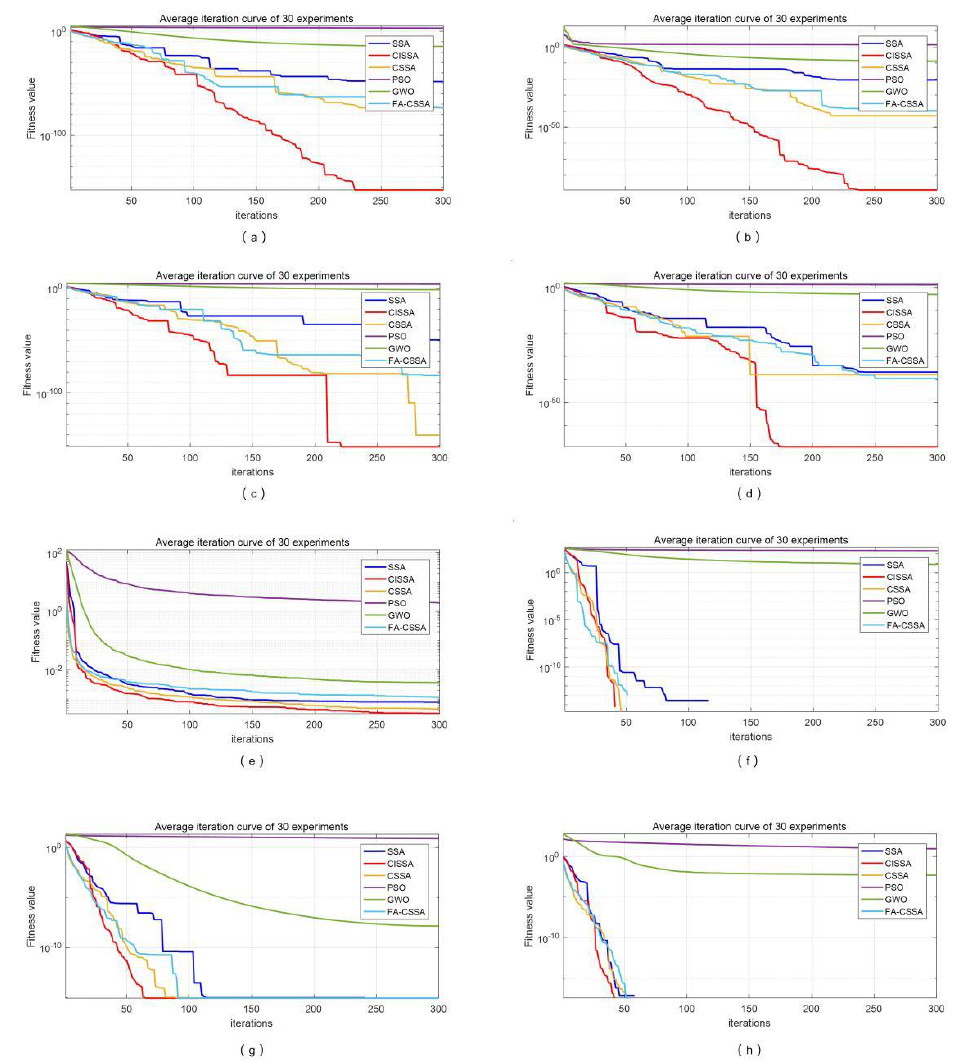
Figure 7. Convergence curves for eight functions: ( a ) indicates the convergence curve for the F1 function; ( b ) indicates the convergence curve for the F2 function; ( c ) indicates the convergence curve for the F3 function; ( d ) indicates the convergence curve for the F4 function; ( e ) indicates the convergence curve for the F5 function; ( f ) indicates the convergence curve for the F6 function; ( g ) indicates the convergence curve for the F7 function; ( h ) indicates the convergence curve for the F8 function. Table 4. Optimal results of different intelligent algorithms.